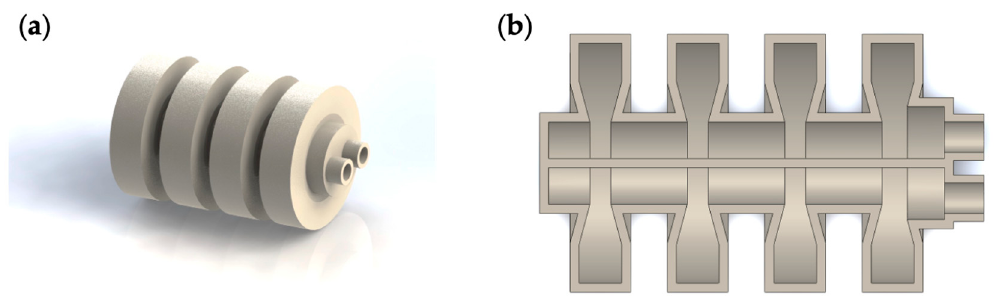
Figure 4. Double-channeled actuator. ( a ) Three-dimensional view; ( b ) sectional view.